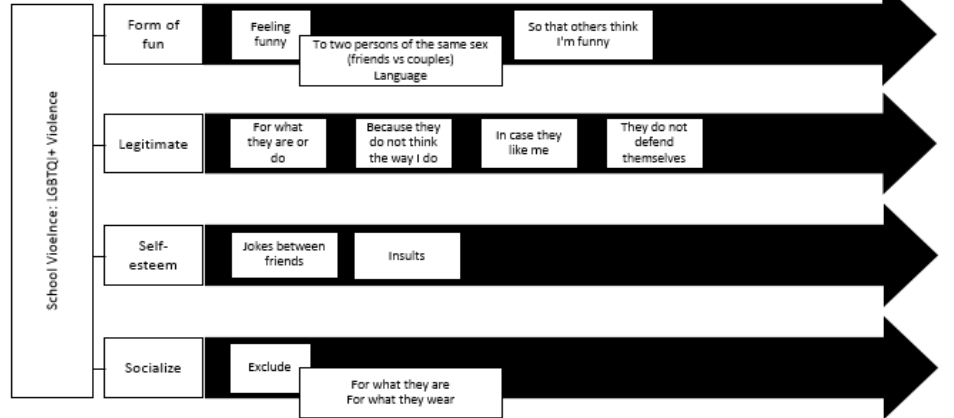
Figure 1. Attitudes toward violence against the LGBTQIA+ community: topics and subtopics.